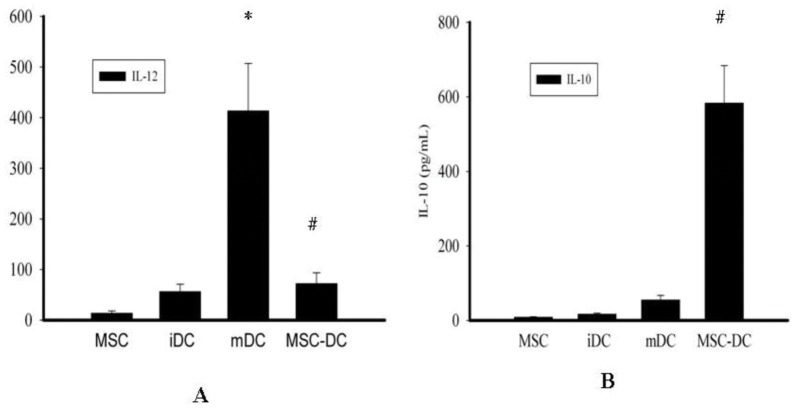
IL-10 and IL-12 secretion as assessed by ELISA.(A) IL-12 secreted in monocultures of MSCs, iDCs and mDCs and in the co-culture of MSC-DC (MSC:DC = 1∶10). (B) IL-10 secreted in monocultures of MSCs, iDCs and mDCs and in the co-culture of MSC-DC (MSC:DC = 1∶10). *P<0.05(mDC group versus iDC group), #P<0.05(MSC-DC group versus MSCs group).